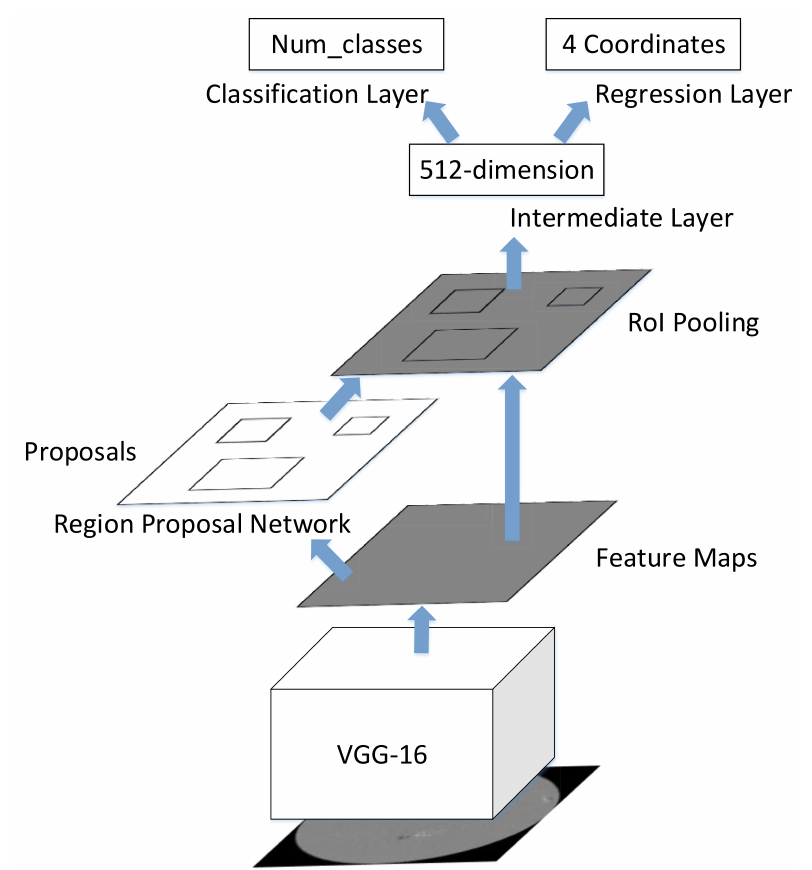
Figure 2. Flow chart of faster R-CNN